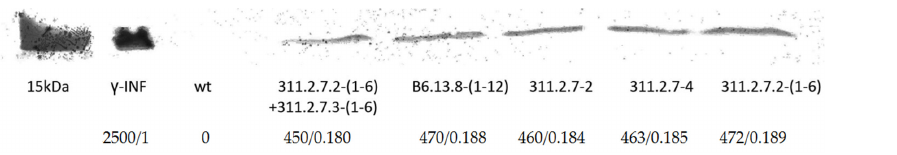
Figure 1. The result of Western blot test of protein samples obtained from T3–4 generations of trans- genic plants. γ -INF—commercial bovine interferon-gamma, wt—non-transgenic tobacco, 15 kDa— molecular weight marker. The numbers correspond to extracts from transgenic plants of lines 311 and B6 of different generations. The bottom line presents the results of the semiquantitative determination of the interferon-gamma content on the blot, rel. units/ µ g. The sensitivity of our version of Western blotting is probably insufficient for a given protein concentration. This Western blot is best viewed as qualitative analysis for the presence or absence of the target protein in the